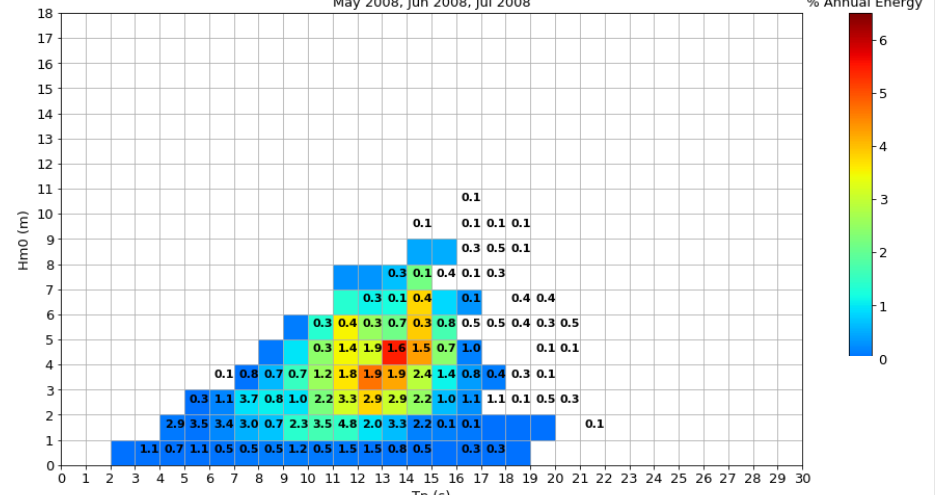
Fig 5. Scaled up Burghead ( H m0 , T p ) % occurrence scatter table (tabulated numbers) for May-Jul 2008 overlaid on Billia Croo ( H m0 , T p ) % annual incident energy scatter colour map for 2008.